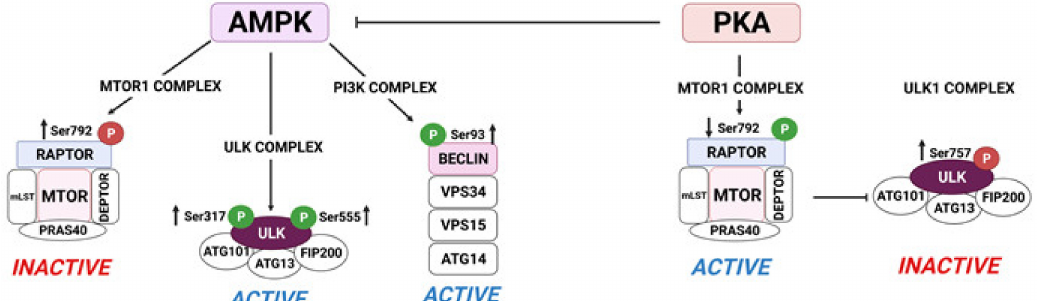
Figure 4. AMPK and PKA signaling oppositely regulate proteins crucial for autophagy initiation in bovine luteal cells. AMPK signaling stimulates autophagy initiation by (1) phosphorylation ULK1 at Ser317 and Ser555 leading to ULK1 activation; and (2) phosphorylation of RPTOR at Ser792 leading to MTOR inactivation. PKA signaling phosphorylates inhibits autophagy initiation by (1) phosphorylation of ULK1 at Ser757 and dephosphorylation of RPTOR at Ser792 allowing maintenance of MTOR activity. 5 (cid:48) -AMP-activated protein kinase (AMPK); protein kinase A (PKA); Unc-51-like kinase 1 (ULK1); regulatory associated protein of MTOR complex 1 (Raptor); MTOR associated protein, LST8 homolog (mLST8); proline-rich AKT substrate of 40 kDa (PRAS40); DEP domain containing MTOR interacting protein (DEPTOR); autophagy related 101 (ATG101); autophagy related 13 (ATG13); FAK family-interacting protein of 200 kDa (FIP200); autophagy related 14 (ATG14). Created with BioRender.com (accessed on 1 September 2021) [209]. “P” in the red circle represents phosphorylation site required for inactivation; “P” in the green circle means phosphorylation required for